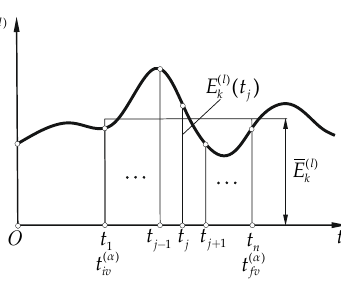
kinetic energy arithmetic average deviation from the integral mean value (Figure 6)